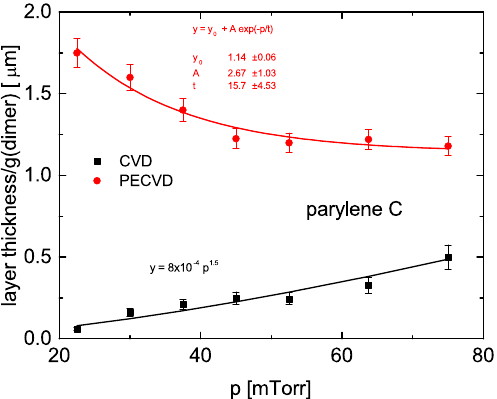
Figure 17. Specific thickness of layers deposited (referred to the mass of dimer) as a function of pressure p for CVD and PECVD (MW power 125 W). Diluent is argon. Plasma activation generates more reactive species than thermal treatment. Due to the lower electron density with increasing pressure, the rate of layer formation decays